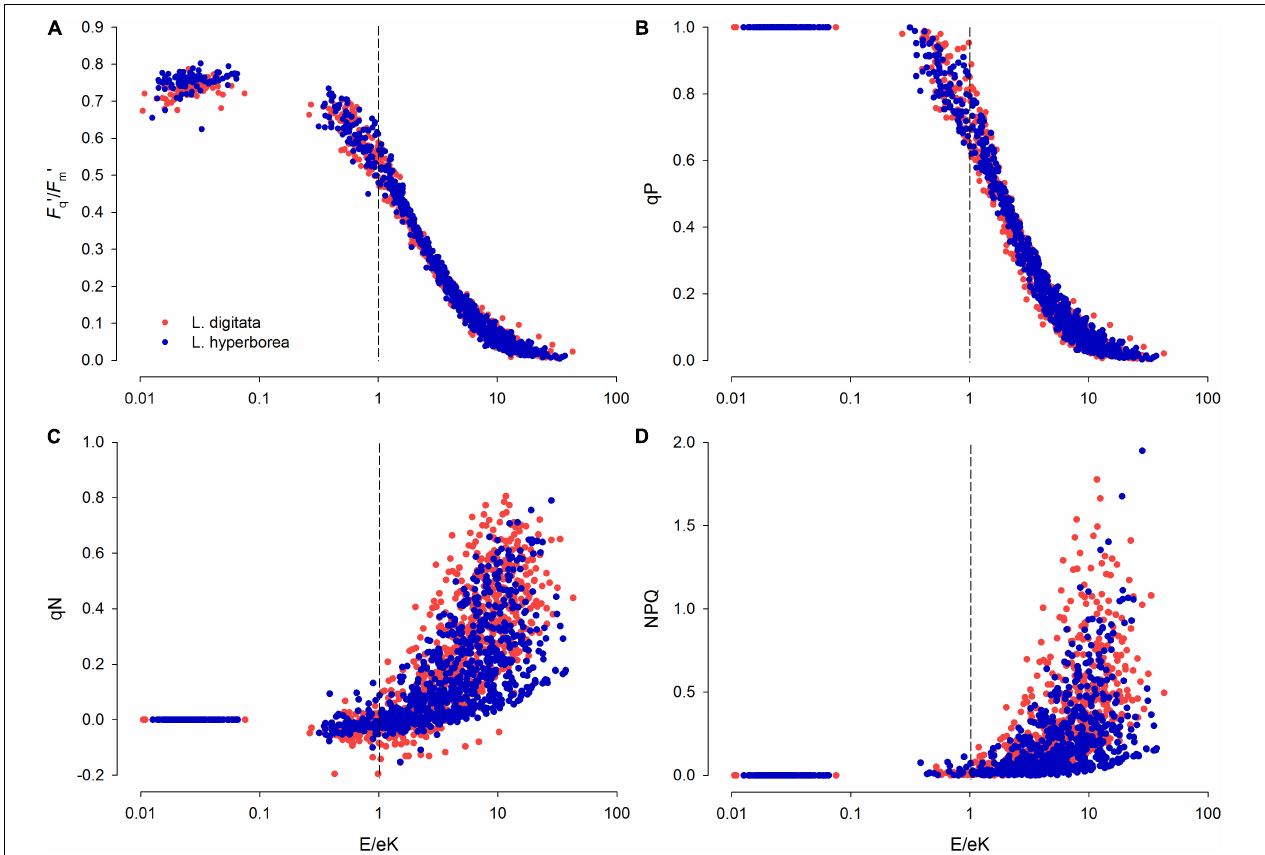
FIGURE 4 | E/ E k against (A) light-acclimated photosynthetic yield ( F q (cid:48) / F m (cid:48) ), (B) photochemical quenching (qP), and (C,D) non-photochemical quenching (qN and NPQ, respectively) for L. digitata (red circles) and L. hyperborea (blue circles), obtained from results from each step of the rapid light curve ( n = 768 data points per species – data pooled across treatments). E, Rapid Light Curve step intensity [photosynthetically active radiation (PAR), µ mol photons m − 2 s − 1 ] and E k , minimum saturation intensity ( µ mol photons m − 2 s − 1 ), calculated from the RLC data. At E/ E k = 1 (vertical dashed line), light level is optimal for photosynthetic efficiency (i.e., neither limiting nor